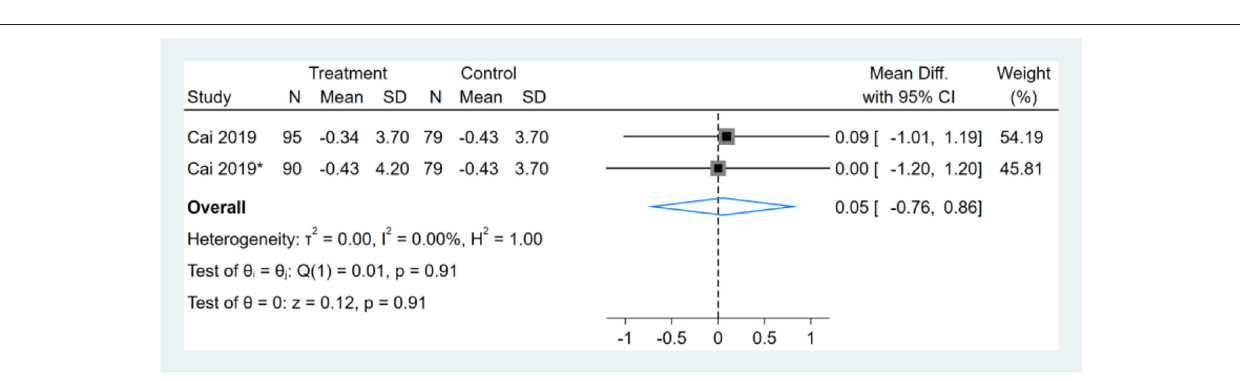
FIGURE 9 | Forest plot analysis showing changes in aspartate transaminase (AST).